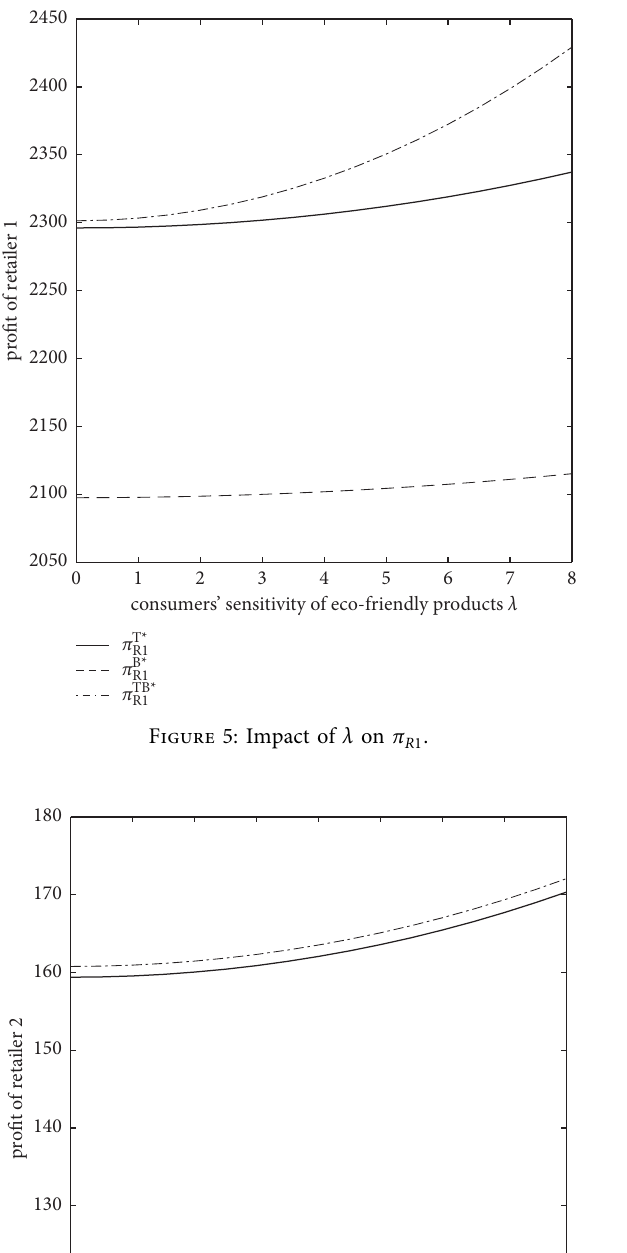
Figure 8: Impact of ϕ on w